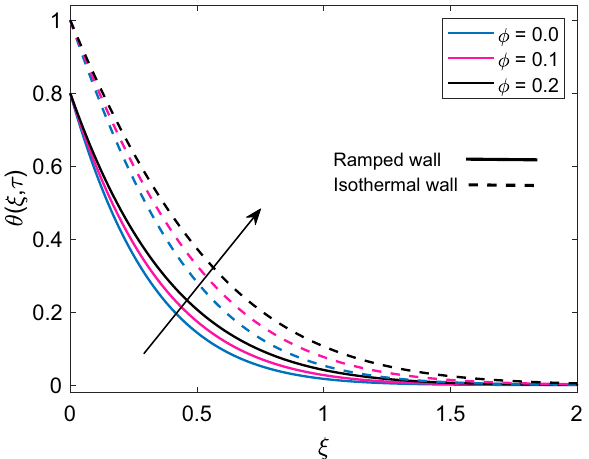
Figure 4. Temperature distribution [Eq. (31)] for various values of φ when Nr = 0.5 and Q = 0.5 .